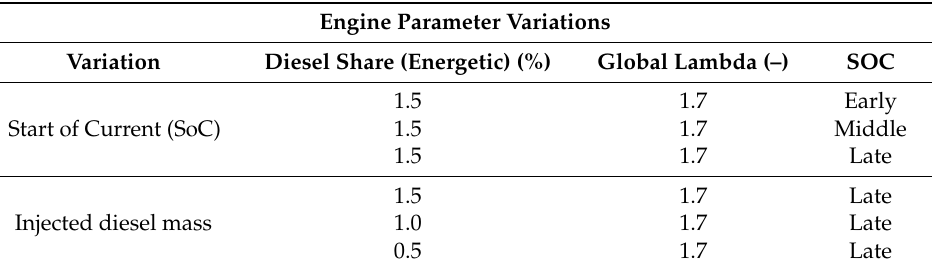
Table 5. Selected operating conditions for the combustion model validation.